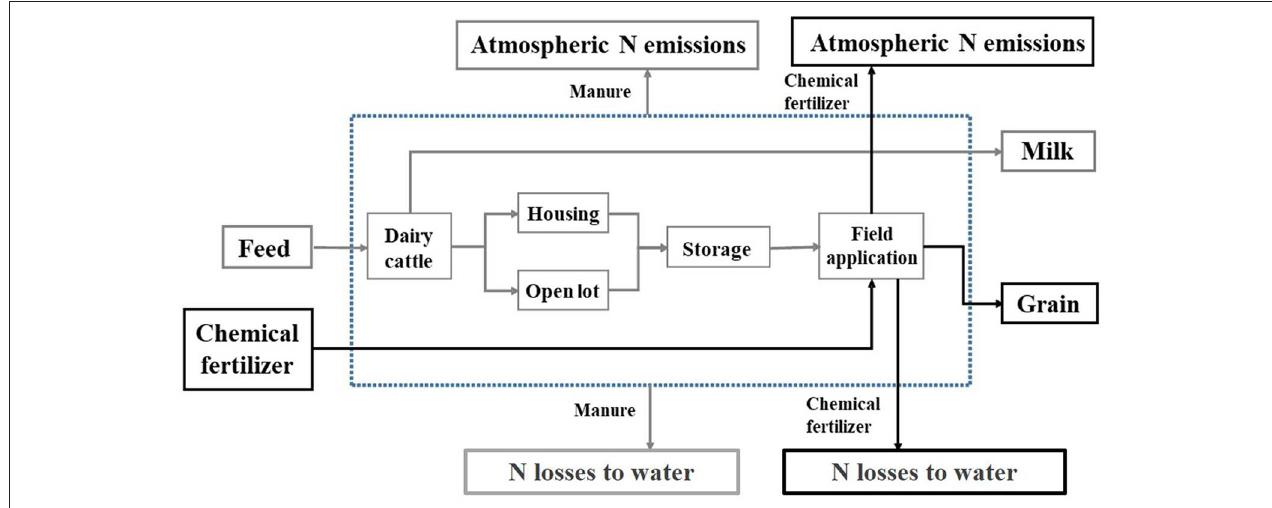
FIGURE 1 | Research boundary of N flow in agriculture and husbandry combined system-dairy cattle as example. (Notes: The dotted line refers to the study boundary of integrated crop and dairy production system. The gray boxes and arrows indicate N flow items of the manure management chain, and the black boxes and arrows indicate the other N flow (not due to cattle production) items of integrated system. Atmospheric N emissions include NH 3 , N 2 O, and N 2